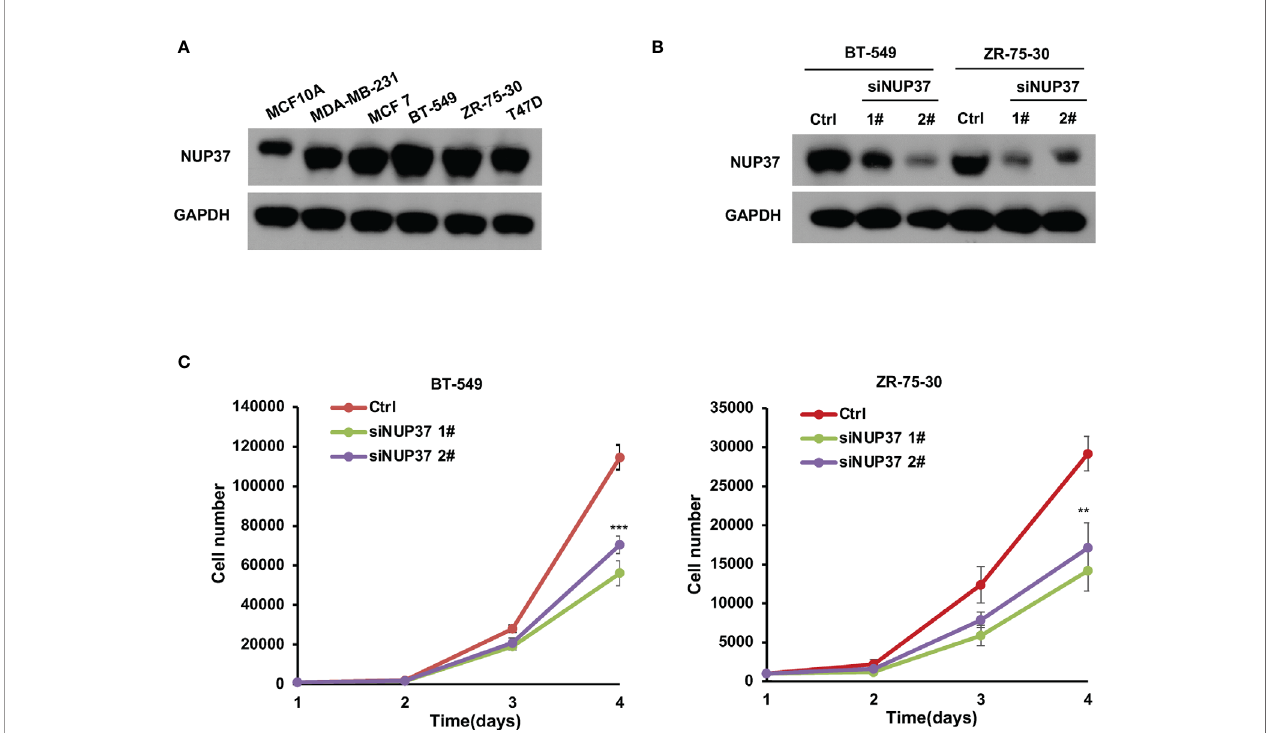
FIGURE 4 | NUP37 knockdown inhibits BRCA cell growth. (A) Western blot analysis con fi rmed a strong expression of NUP37 protein in the BRCA cells MDA-MB- 231, MCF7, BT-549, ZR-75-30, and T47D compared with MCF10A. GAPDH was used as a loading control. (B) Western blot analysis of NUP37 protein levels in BT- 549 and ZR-75-30 cells transfected with siNUP37 or siRNA control for 72 h. GAPDH was used as a loading control. (C) The proliferation of BT-549 and ZR-75-30 cells transfected with siNUP37 or siRNA control for the indicated time was assessed by counting the number of cells. The experiments were performed at least in triplicate, and the results are presented as the mean±s.d. The data were analyzed by Student ’ s t-test (**p<0.01;